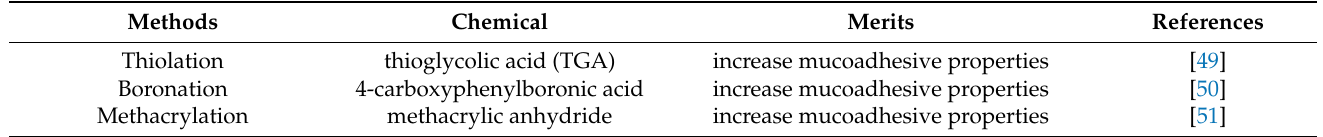
Table 1. Description of methods to modify chitosan